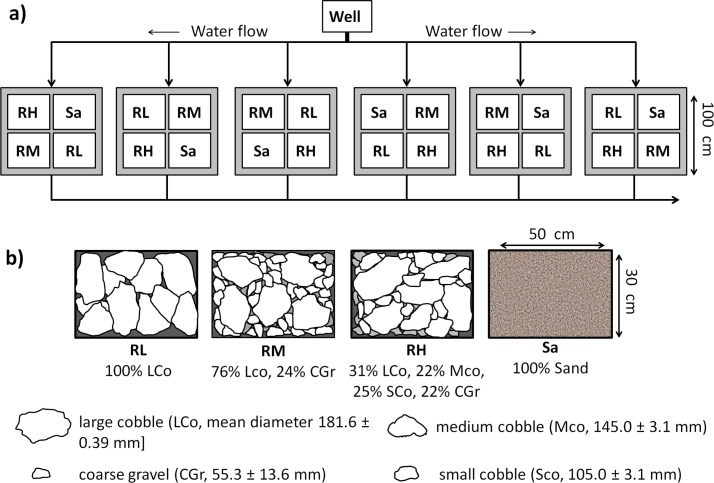
Diagram of experimental system setup: tanks (shadowed squares), boxes (empty squares) and water flow are illustrated.a) RH = Rock High; RM = Rock Medium; RL = Rock Low; Sa = Sand. b) Grain size compositions of the experimental groups contained in each tank.